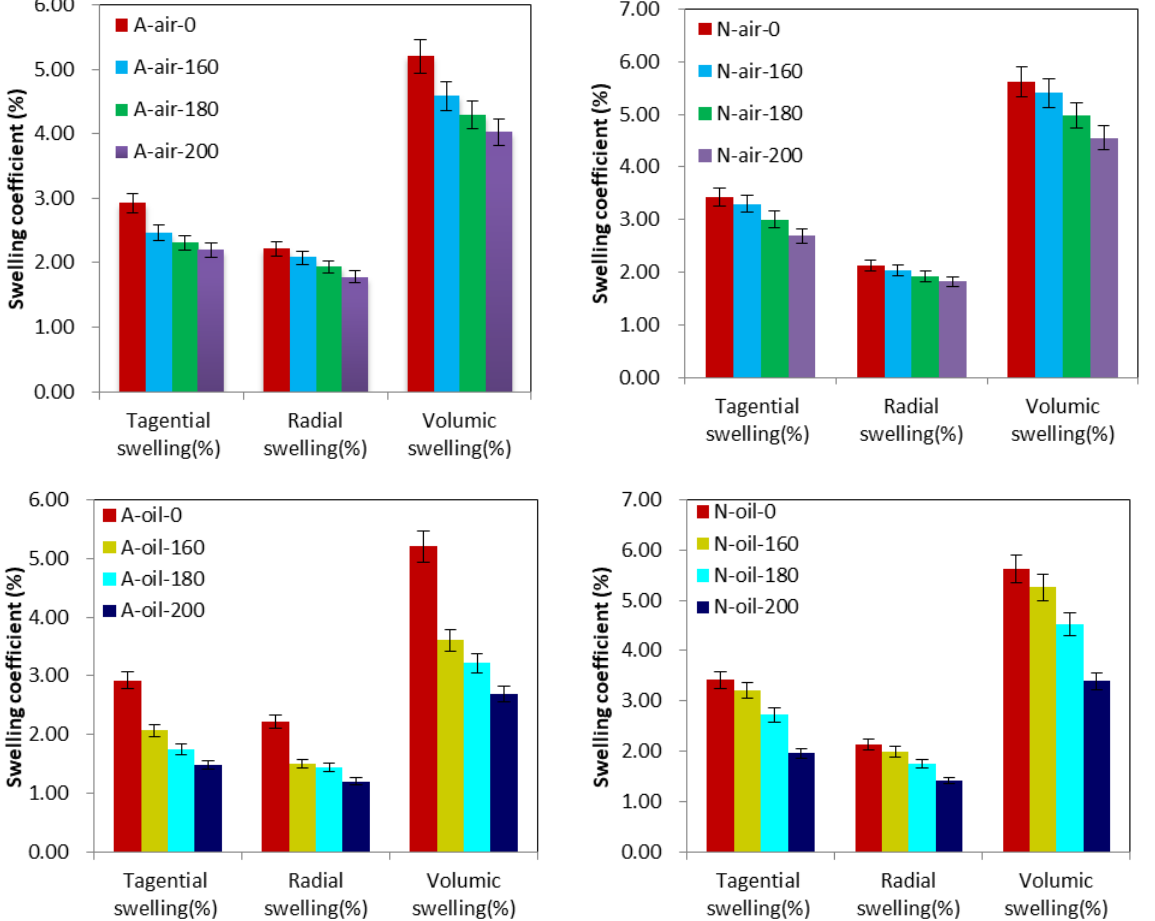
Figure 5. Swelling coefficients of Afrormosia and Newtonia heat-treated under air or palm oil.